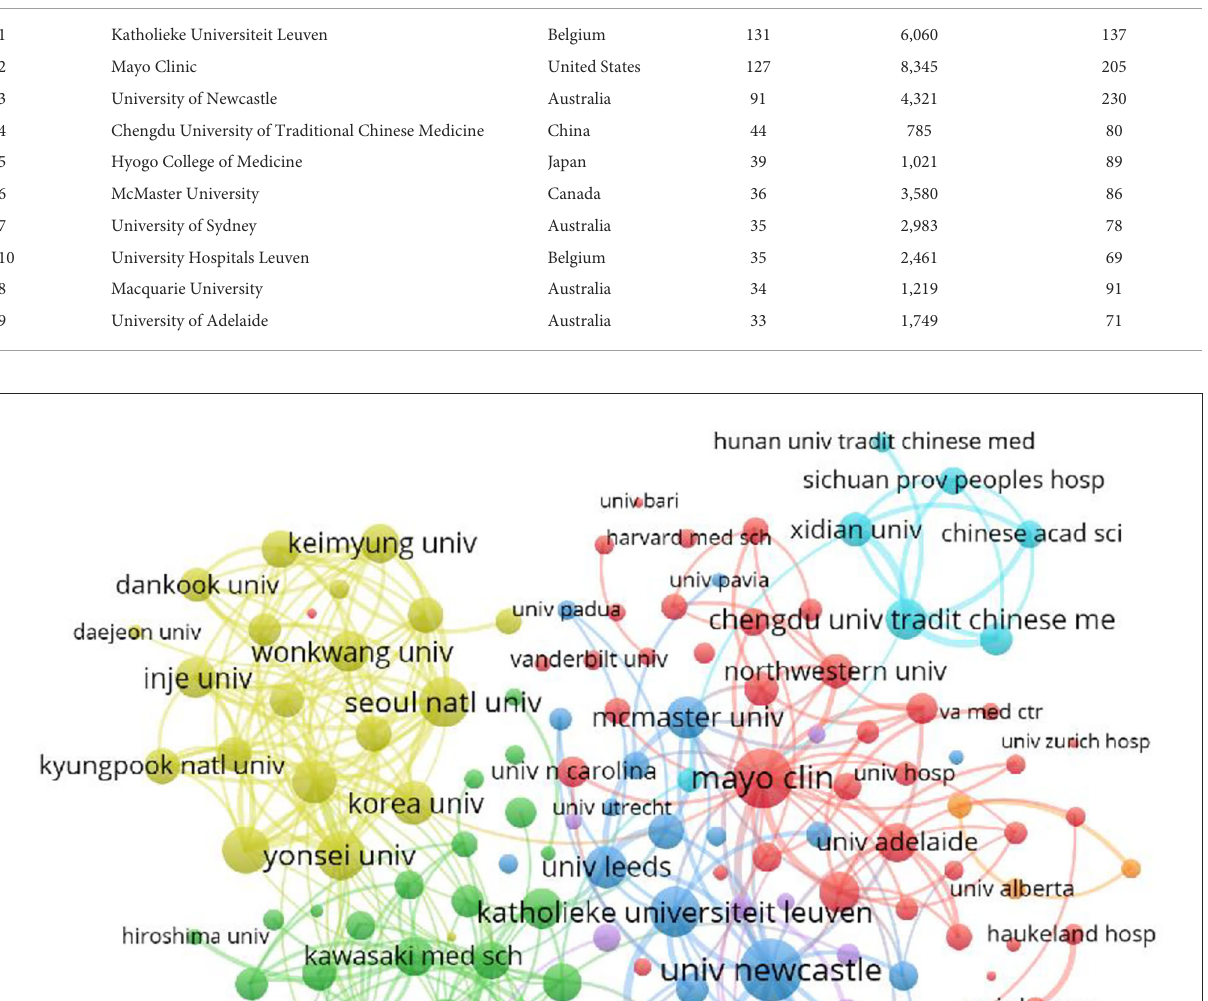
collaborative teams have been formed in the field of FD research. The three most productive organizations,